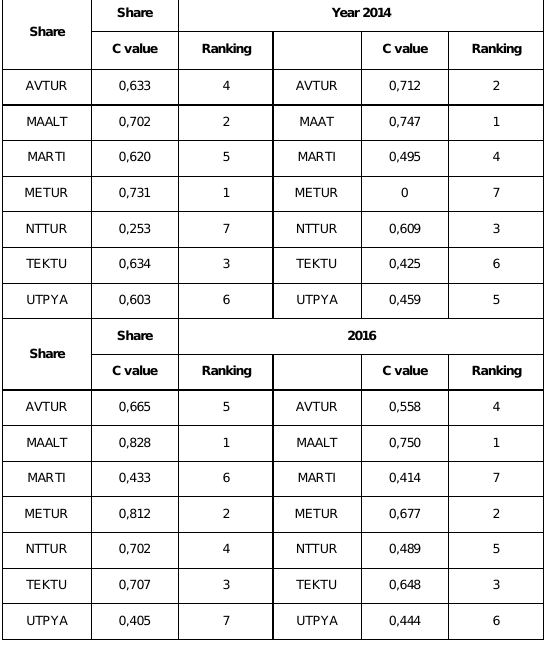
Ideal solution relative affinity values in our Table 14: Ideal Solution Relative Affinity Values – Years 2014 and